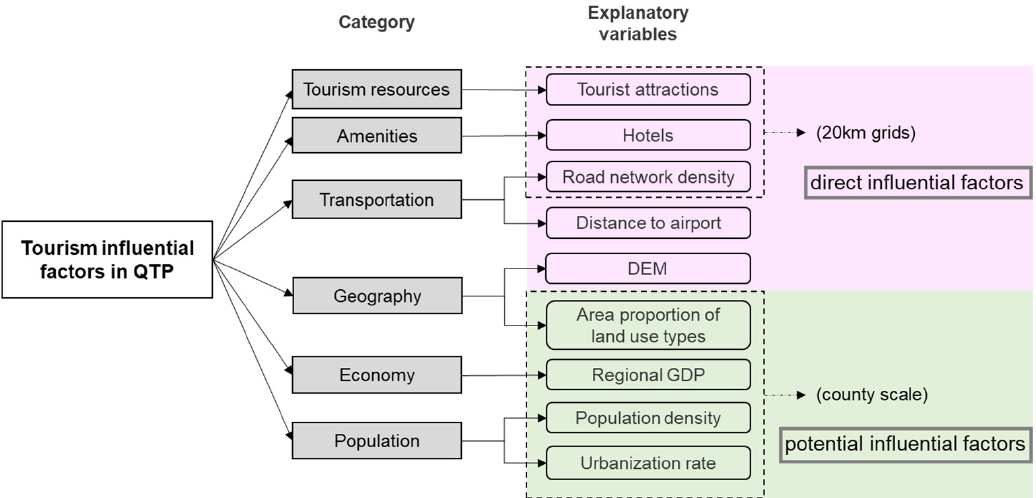
Figure 2. Classification of influential factors.